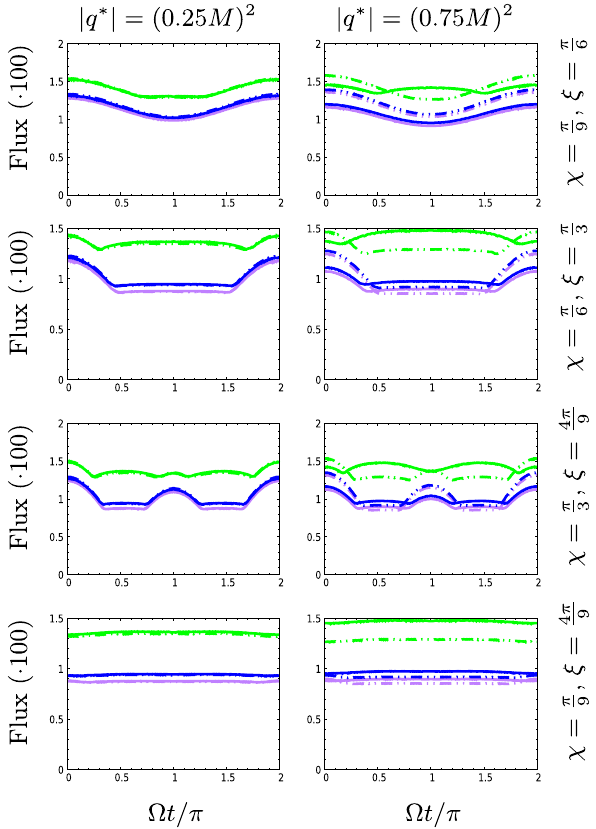
Fig. 11 Same configuration as inFig.10 but for h = 0. We see that, for aconstantplasmadensity,lowfrequenciesdonotsatisfythepropagation conditions in the vicinity of the